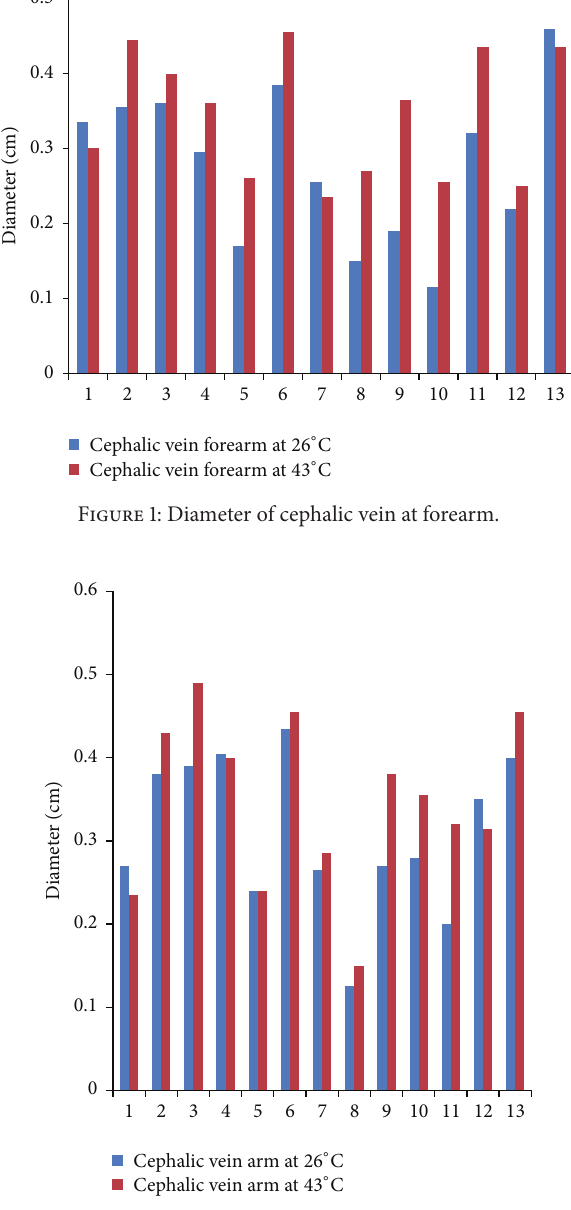
Figure 2: Diameter of cephalic vein at